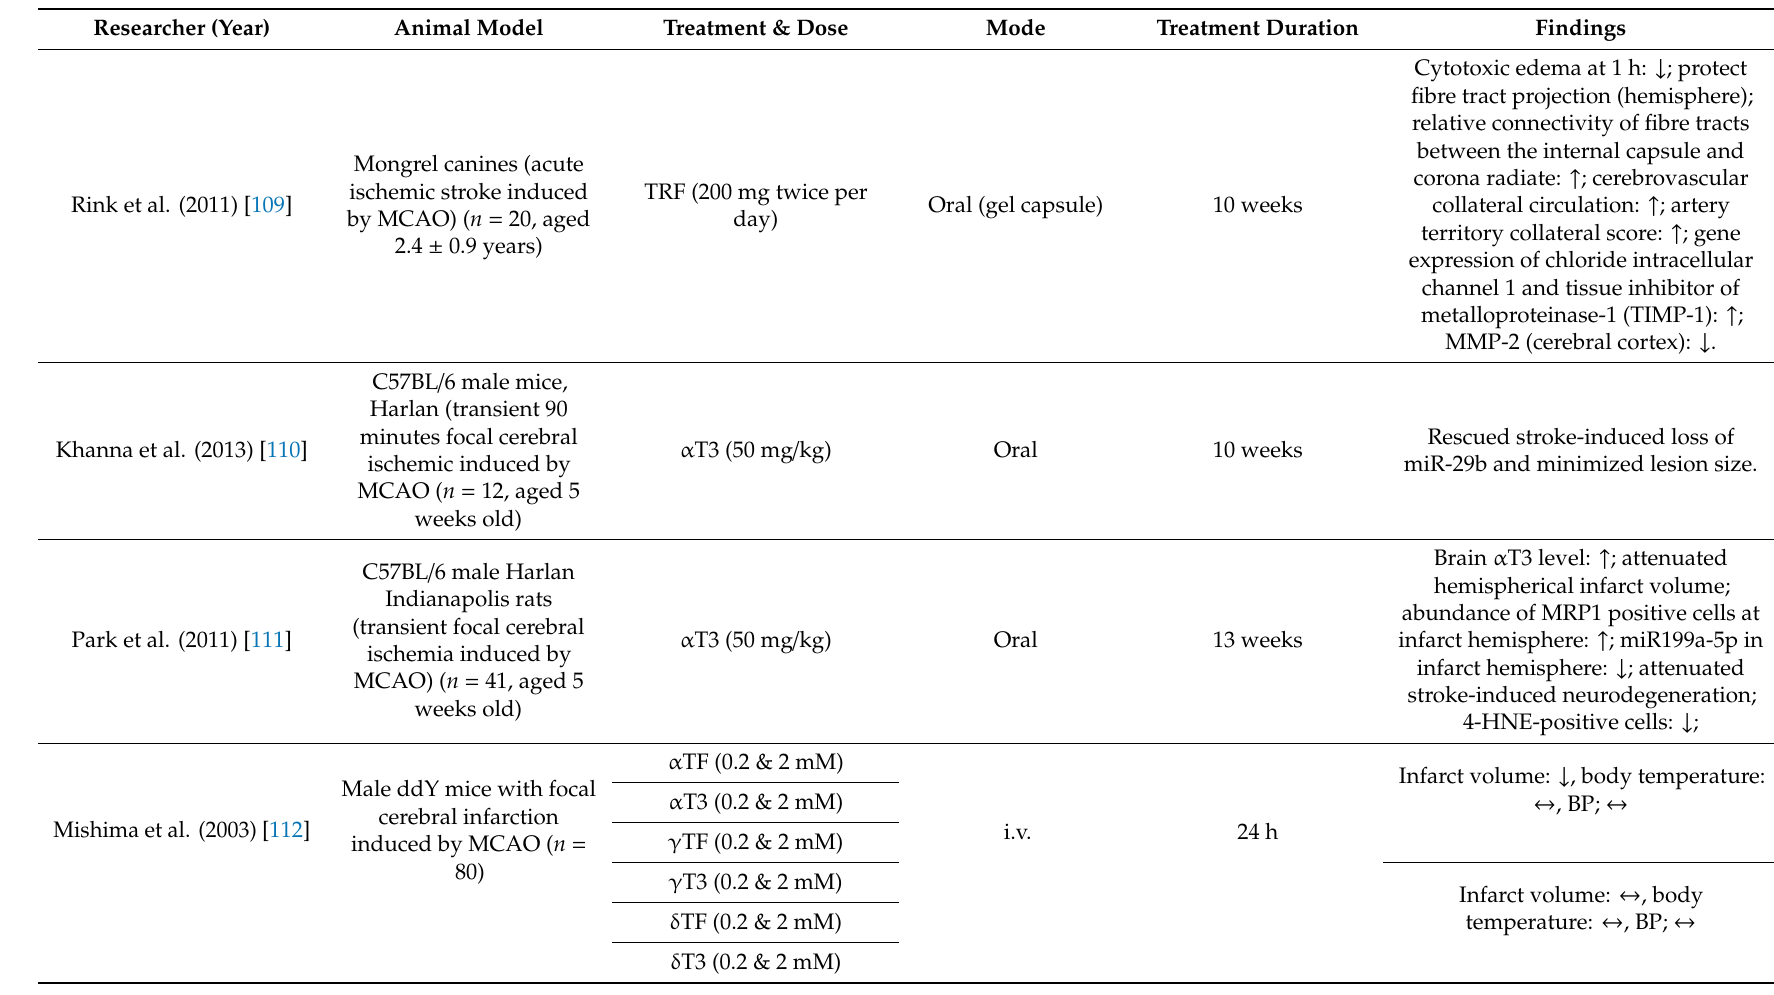
Table 6. E ff ects of T3 on cerebrovascular diseases in